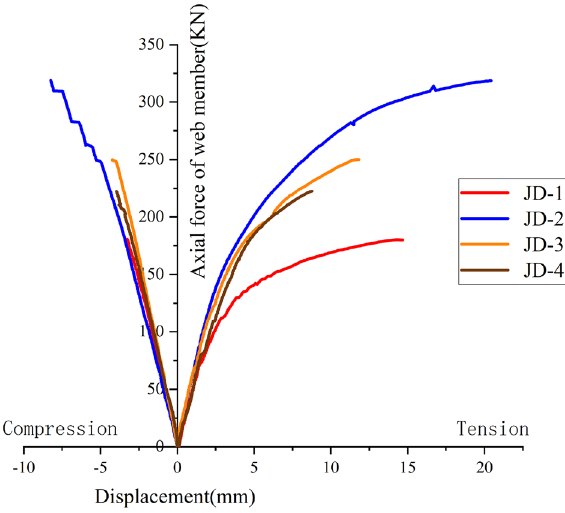
Figure 6. Axial force–displacement curve of web member.